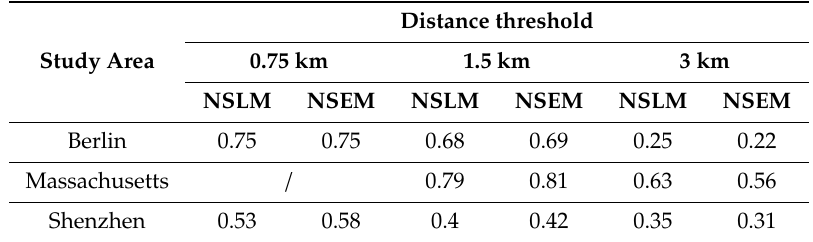
Table 4. R 2 of linear fitting NLI values of two models under di ff erent distance thresholds.